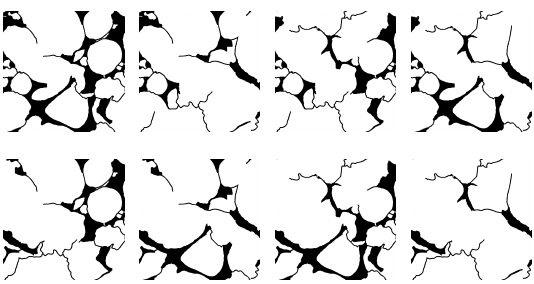
Figure 9. Wang tile set W8/2-2, tile size h = 1000 px, overlap ω = 100 px, raw